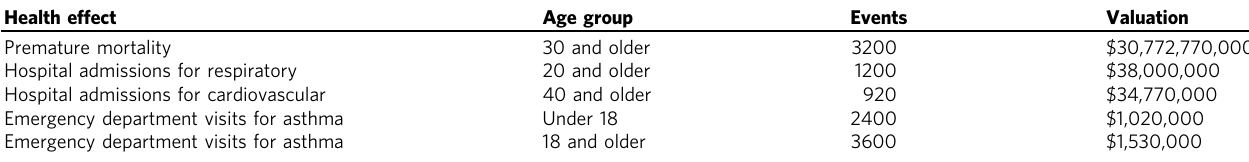
Table 1 Annual health events attributable and cost of PM 2.5 exposure compared to background levels (2005 – 2007)